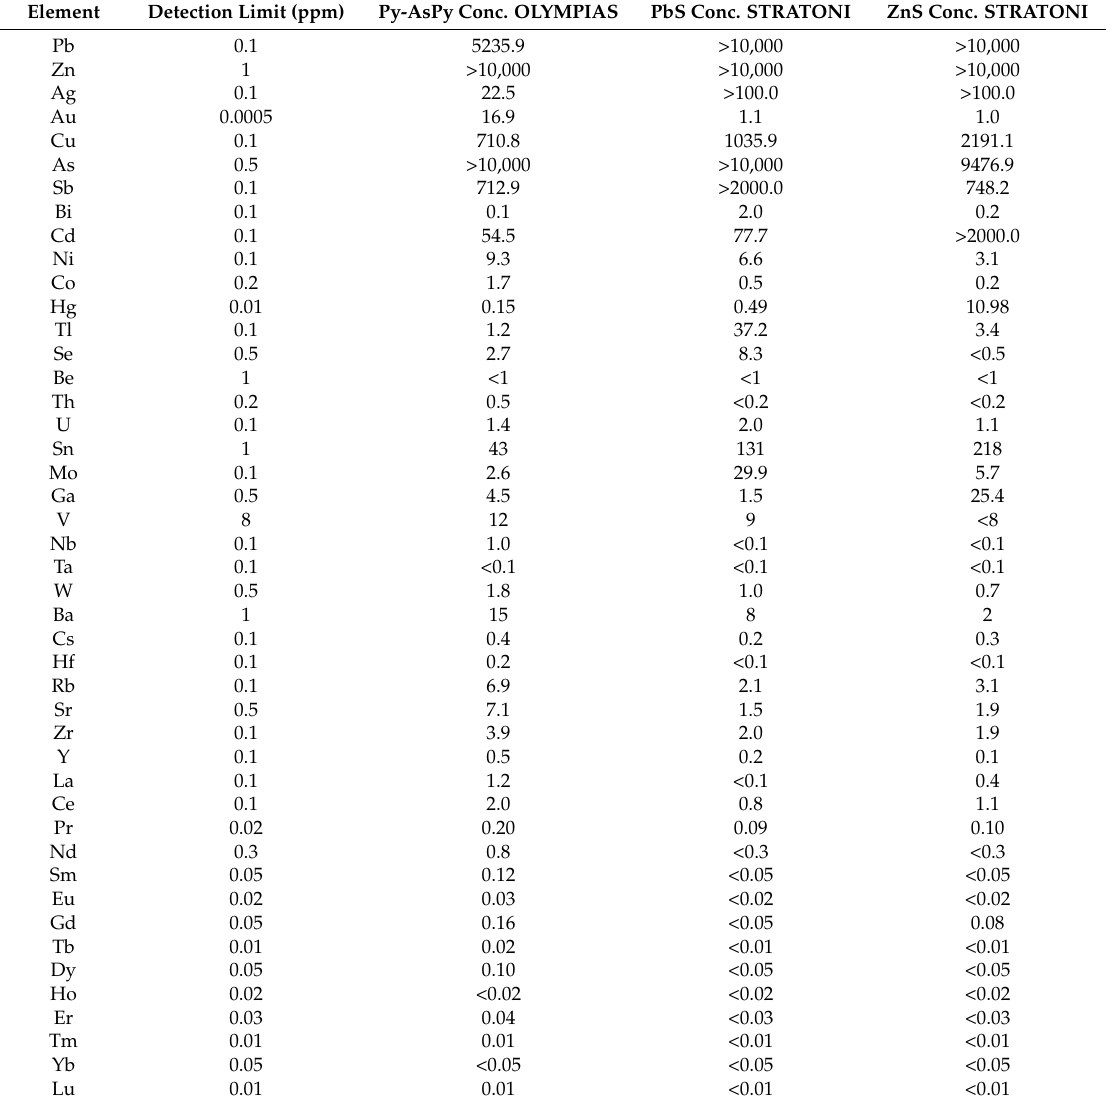
Table 4. Trace and critical element concentrations of the studied Kassandra mines